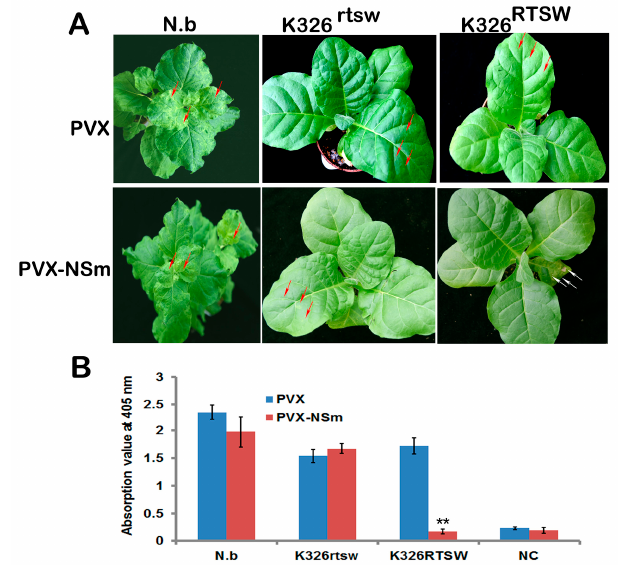
Figure 3. Transient expression of TSWV NSm using argoinfection of Potato virus X (PVX)-based vectors. ( A ) Phenotypes of tobacco leaves were agroinfiltrated with PVX or PVX-NSm constructs. Photographs were taken at 12 dpi. PVX-induced faint chlorotic spots are indicated with red arrows, and HR symptoms in inoculated leaves are indicated with white arrows. N.b, Nicotiana benthamiana ; K326 rtsw , plants derived from the BC5F1 population of Polalta × K326 lacking the RTSW gene and susceptible to TSWV; K326 RTSW , plants derived from the same BC5F1 population, but carrying the RTSW gene and resistance to TSWV. ( B ) ELISA of PVX titer in systemic leaves shown in panel (A). Data represent mean ± SD in one representative experiment ( n = 6). Un-inoculated healthy N. benthamiana plants served as a negative control (NC). Asterisks indicate statistically significant differences (**, p < 0.01; Student’s t -test).